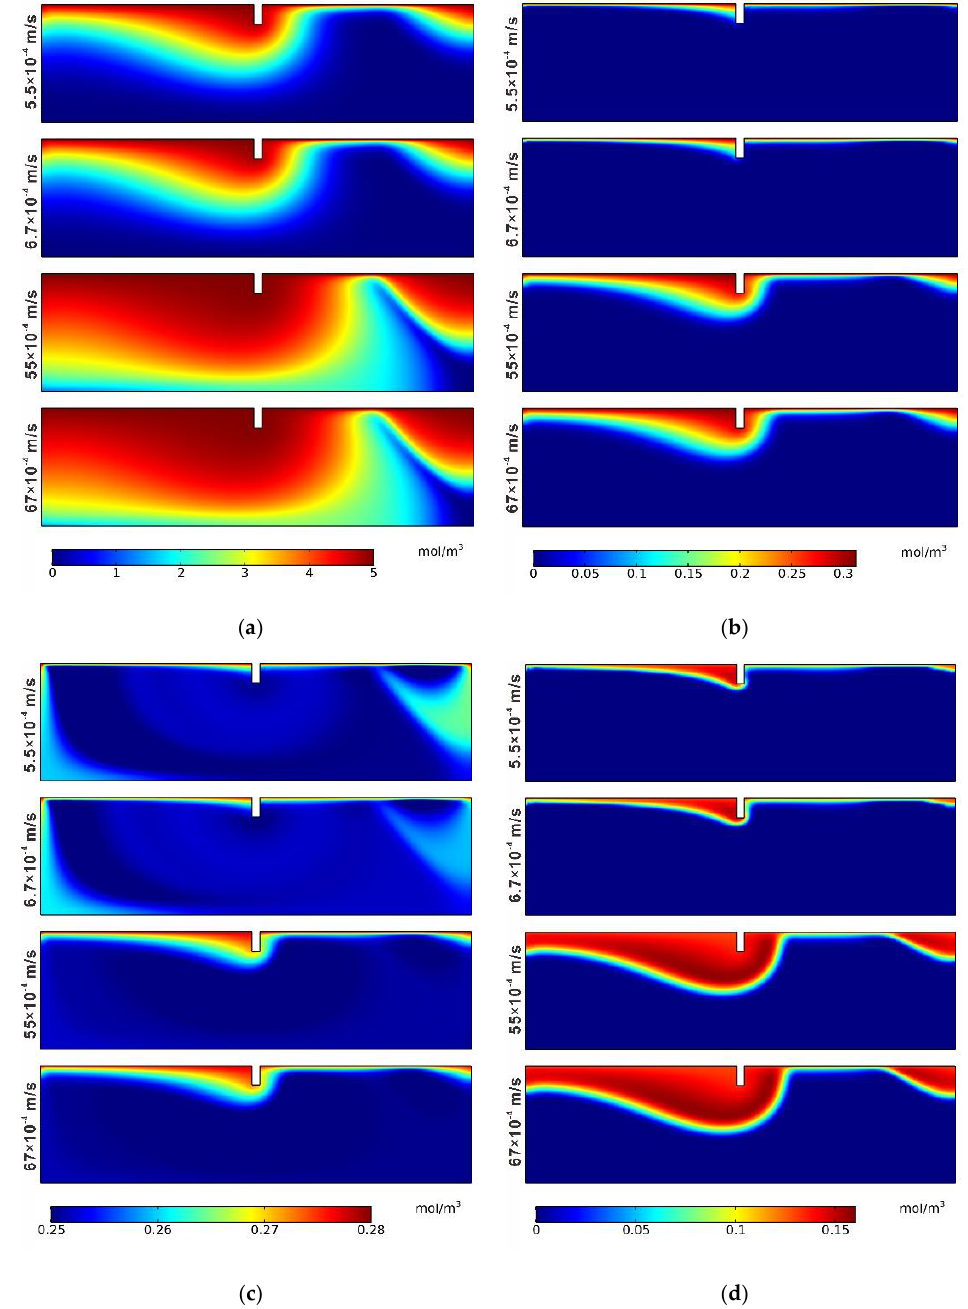
Figure 12. Concentration distributions of the four species for different permeability coefficients: ( a ) DOC; ( b ) DO; ( c ) NH 4+ ; ( d ) NO 3 − .